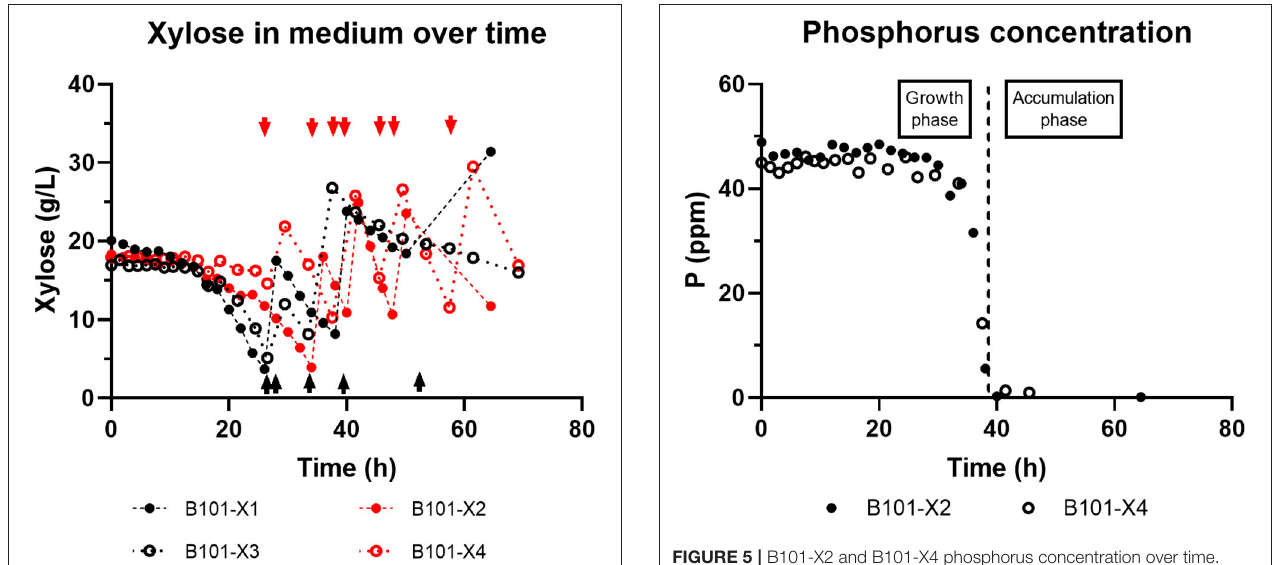
FIGURE 5 | B101-X2 and B101-X4 phosphorus concentration over